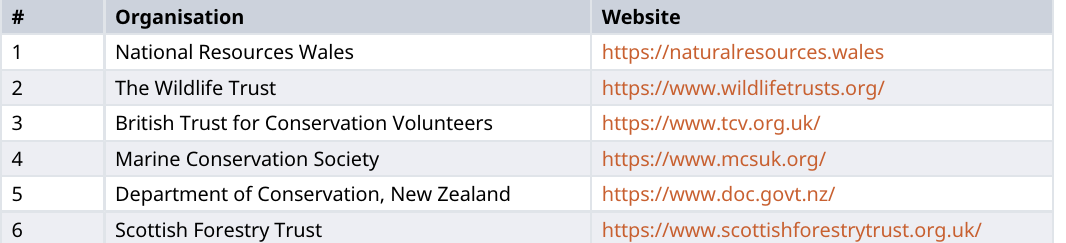
Table 1. Organisational websites consulted for additional